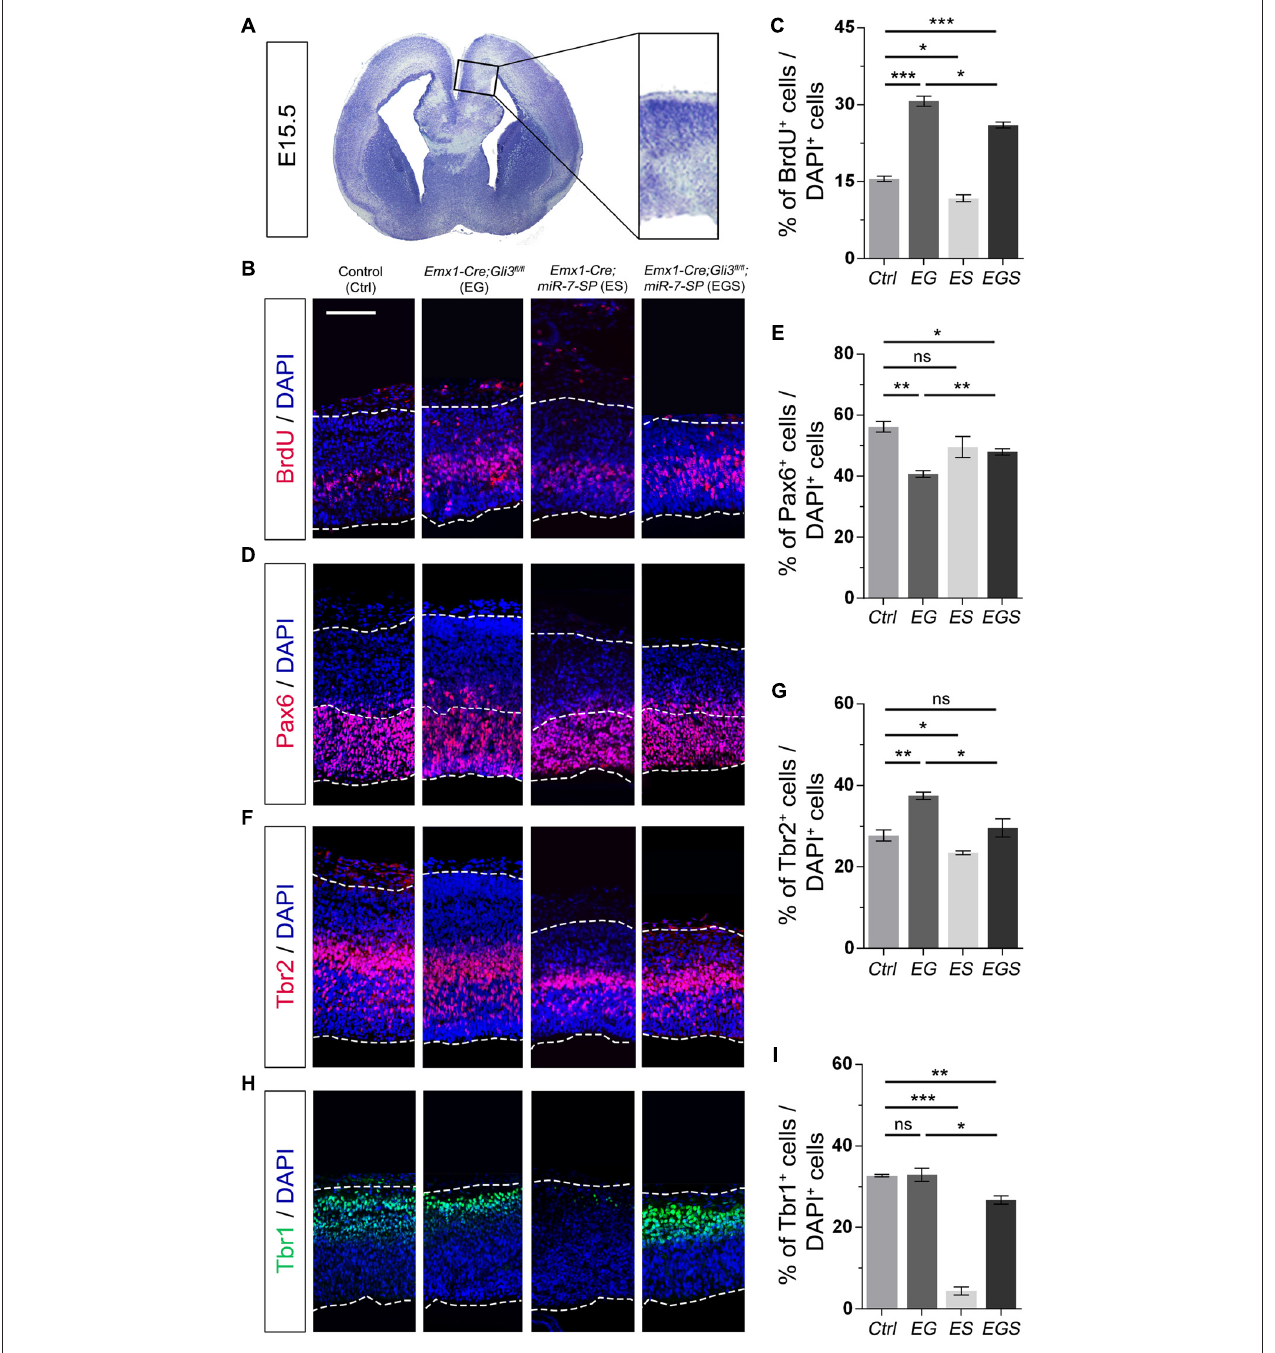
FIGURE 3 | Gli3 effects on proliferation of neural progenitors (NPs) in the cortical midline. (A) The position that was measured for the embryonic day 15.5 (E15.5) midline cortex. (B,C) Cortical deficiency of Gli3 increased the proportion of BrdU + cells vs. DAPI + cells. Knockdown of miR-7 decreased the proportion of BrdU + cells vs. DAPI + cells. Silencing miR-7 failed to rescue the dysregulation of BrdU + cells in the Gli3 -deficient brain. (D,E) Cortical deficiency of Gli3 suppressed the population of cells expressing the radial glial cell (RGC) marker Pax6 + /DAPI + , which was completely rescued by silencing miR-7. Silencing miR-7 showed no significant changes of the proportion of cells expressing RGC marker Pax6 + /DAPI + . (F,G) Losing Gli3 increased the ratio of intermediate progenitor (IP) marker Tbr2 + /DAPI + , which was restored by blocking miR-7. Knockdown of miR-7 did not affect the ratio of IP marker Tbr2 + /DAPI + at E15.5. (H,I) No difference was observed in Tbr1 + cells vs. DAPI + cells in EG mice, which was significantly reduced by silencing miR-7. Cortical deficiency of miR-7 decreased the proportion of Tbr1 + cells vs. DAPI + cells. The markers BrdU, Pax6, Tbr2, Tbr1 and DAPI stained for proliferative NPs, RGCs, IPs, newborn neurons and all cells, respectively. Values represent mean ± SEM. n > 9. ∗ P < 0.05; ∗∗ P < 0.01; ∗∗∗ P < 0.001; ns, not significant. One-way ANOVA with post hoc test was used. Scale bar = 100 µ m.